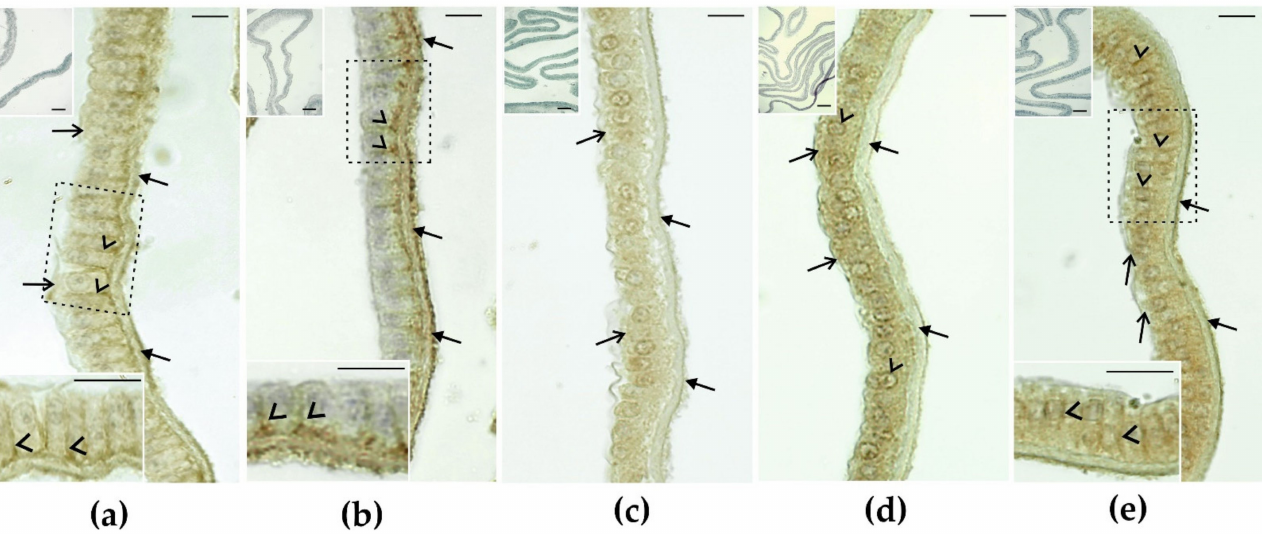
Figure 2. Immunohistochemical staining for cell junction proteins in the inner perivitelline layer (IPVL) in mature oocyte. Adherens junction proteins: ( a ) N-cadherin and ( b ) β -catenin; Tight junction proteins: ( c ) occludin and ( d ) tight junction protein-1; and gap junction protein: ( e ) connexin 43. All sections were counterstained with Mayer’s haematoxylin. Bars = 10 µ m. Frames indicate the location of the higher magnification view. ( a ) Positive diffuse staining for N -cadherin in the IPVL (arrows) and the granulosa cell (GC) layer (open arrows) is visible. Note weak-to-moderate linear staining in the lateral plasma membranes between neighboring cells of the GC layer (arrowheads); ( b ) A very strong signal of β -catenin is localized to the IPVL (arrows), while that of moderate intensity is observed in the lateral plasma membranes of the GC layer (arrowheads). For details, see the higher magnification panel. ( c ) Positive staining for occludin is restricted to the apical compartment of the GC layer (open arrows), whereas no positive signal is observed in the IPVL (arrows); ( d ) The strong tight junction protein-1 signal is either dispersed at the cytoplasm of the GC layer (open arrows) or visible in the linear staining pattern of the GC perinuclear cytoplasm (arrowheads). No positive signal for the tight junction protein-1 is localized to the IPVL; ( e ) Positive staining for connexin 43 is visible in the IPVL (arrows) and the GC layer (open arrows). Connexin 43 is distributed in a linear array between granulosa cells (arrowheads). For details, see the higher magnification panel. No immunopositive staining for, N -cadherin, β -catenin, occludin, tight junction protein-1 and connexin 43 was observed when the primary antibodies were omitted ( a – e , inserts in upper left corners of